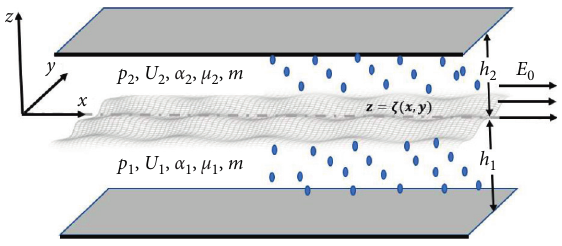
Figure 1: A sketch of the physical